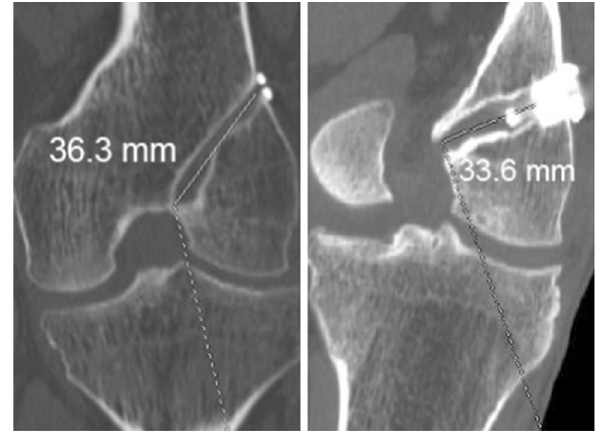
Fig. 3 Tunnel length was evaluated on selected images, calculating from intra-articular to extra-articular